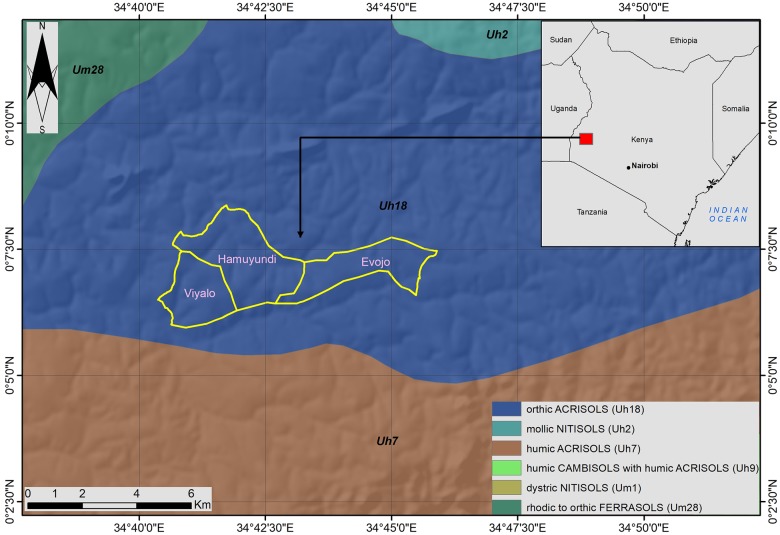
The study area relative to the soils.